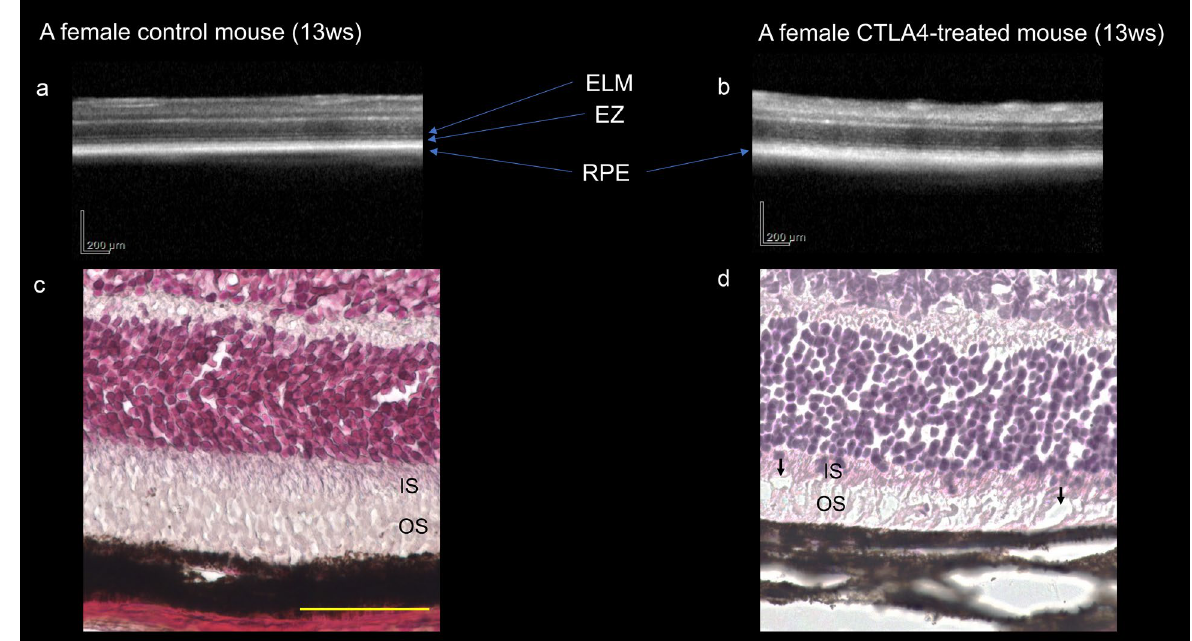
Figure 2. ( A ), ( B ) Retinal structure in control and anti-CTLA4-treated eyes examined using optical coherence tomography. Treated eyes exhibited an obscured external limiting membrane (ELM) and ellipsoid zone (EZ) as compared to control eyes. ( C ), ( D ) Haematoxylin and eosin staining for control and anti-CTLA4-treated eyes. Treated eyes exhibited destruction of outer photoreceptor segments and choroidal thickening. Black arrows indicated vacuolisations. Scale bar: 50 μm.